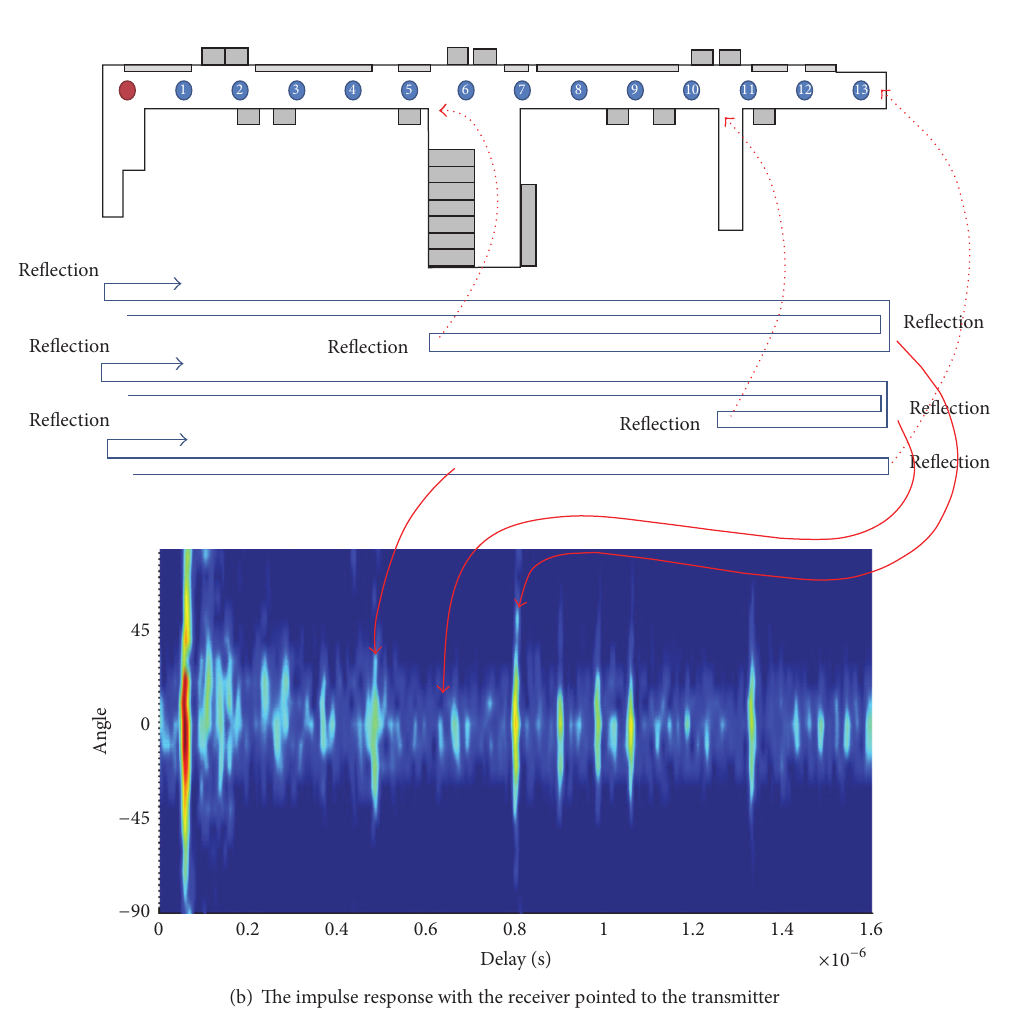
Figure 6: Impulse response obtained at